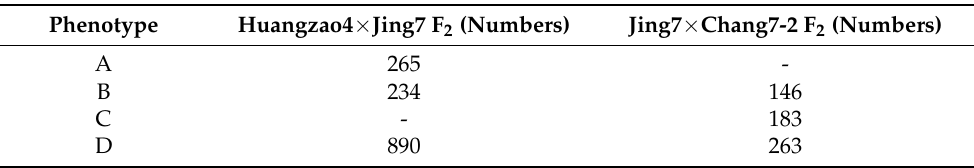
Figure 3. Different tassel symptoms of plants infected with Sporisorium reilianum in F 2 populations: ( a ) typical Huangzao4 plants in Huangzao4×Jing7 F 2 population; ( b ) typical Jing7 plants in the Huangzao4×Jing7 F 2 population; ( c ) typical Chang7 ‐ 2 plants in the Jing7×Chang7 ‐ 2 F 2 population. Table 1. Numbers of different tassel symptoms of maize infected with Sporisorium reilianum in two F 2 populations.